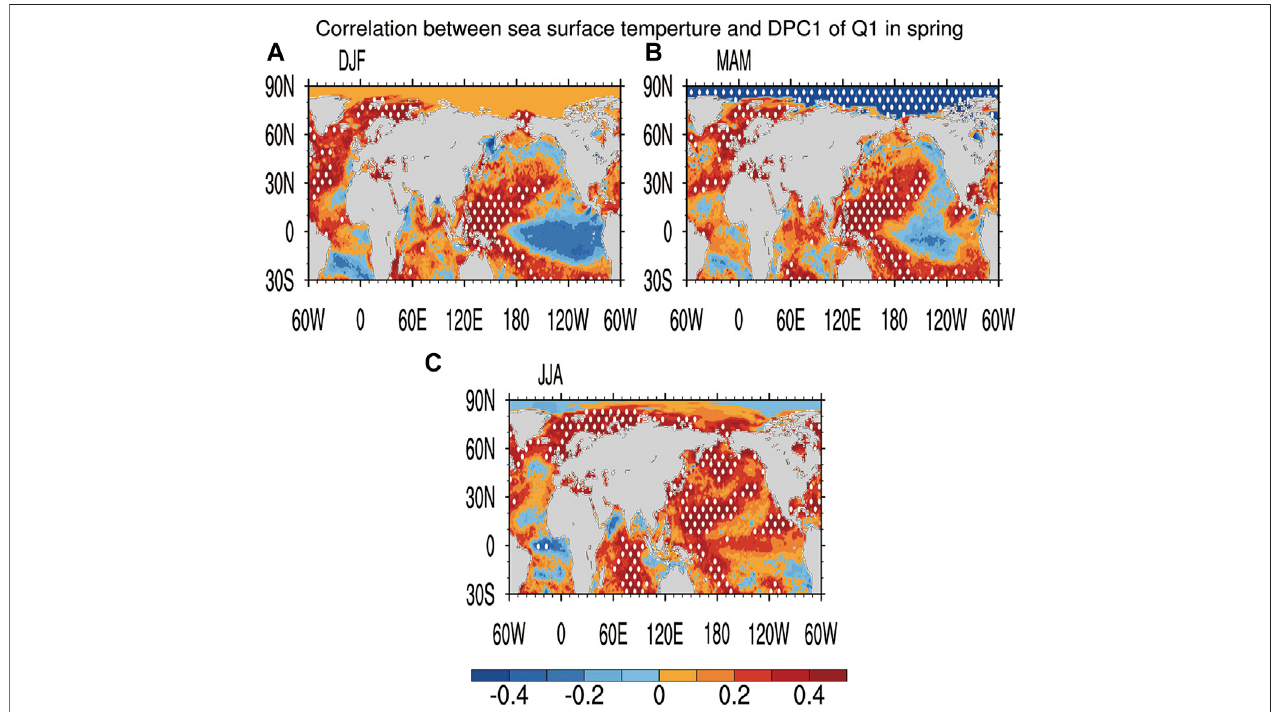
FIGURE9| Distributionofthecorrelationcoef fi cientsbetweenDPC1and theSSTinthetimeperiod 1979 – 2020in (A) previouswinter, (B) springand (C) summer. The white dots indicate statistical signi fi cance at the 95% con fi dence level.